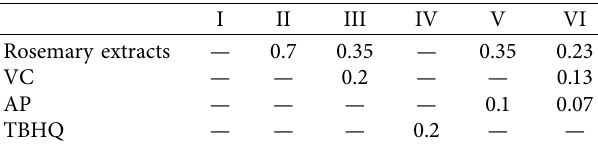
Table 1: Combinations of different types and quantities of anti- oxidants (g/kg) in six groups. I II III IV Rosemary extracts — — — —